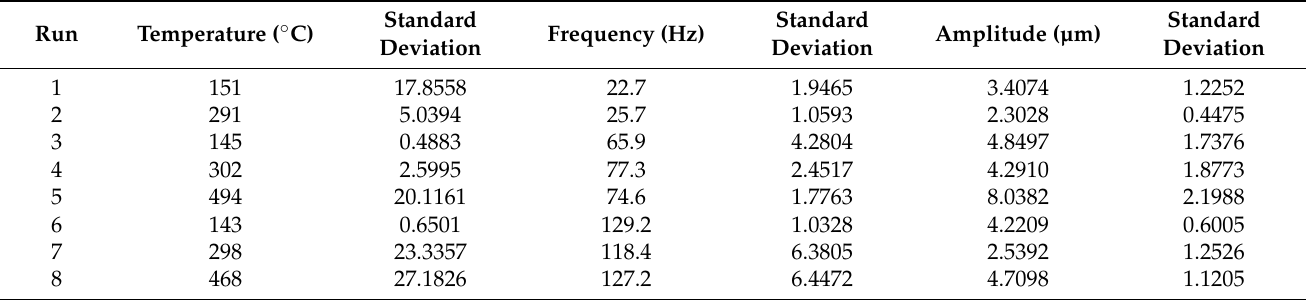
Table 2. Average levels of the experimental